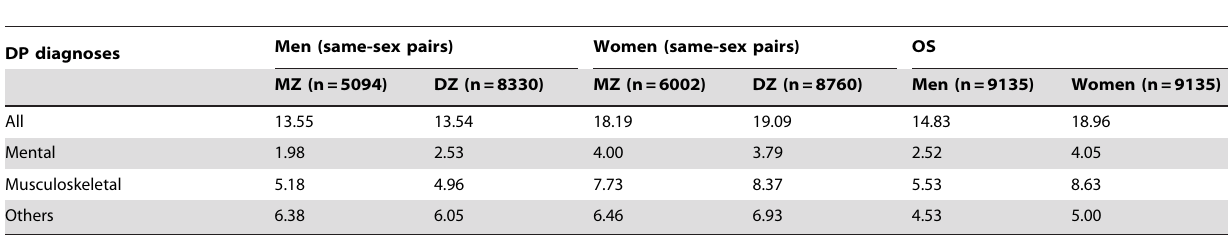
Table 1. Cumulative incidence (%) of the granting of disability pension (DP) by sex, zygosity, and diagnosis group.